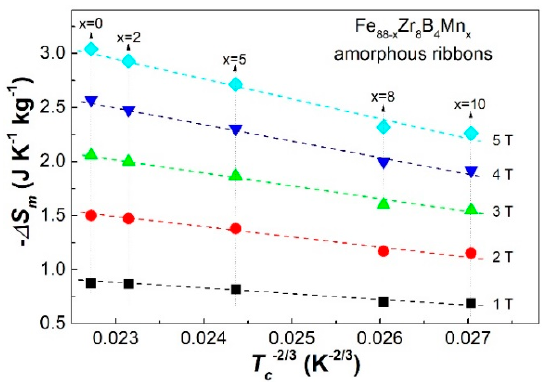
Figure 8. the −Δ S mpeak vs T c -2/3 plots under a field of 1T, 2T, 3T, 4T, 5T for the Fe 88-x Zr 8 B 4 Mn x amorphous Figure 8. The − ∆ S mpeak vs. T c − 2/3 plots under a field of 1T, 2T, 3T, 4T, 5T for the Fe 88 − x Zr 8 B 4 Mn x samples. amorphous